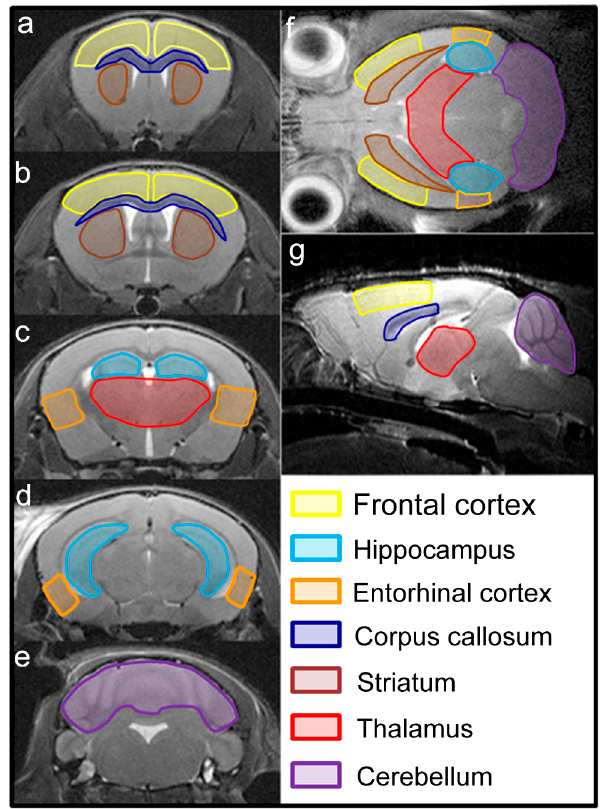
Figure 1. Seven regions of interest (ROI). The schematic boundaries of ROIs were drawn on the coronal ( a – e ), axial ( f ), and sagittal ( g ) T2-weighted images of a mouse brain according to the mouse brain atlas by Paxinos and Watson [12].